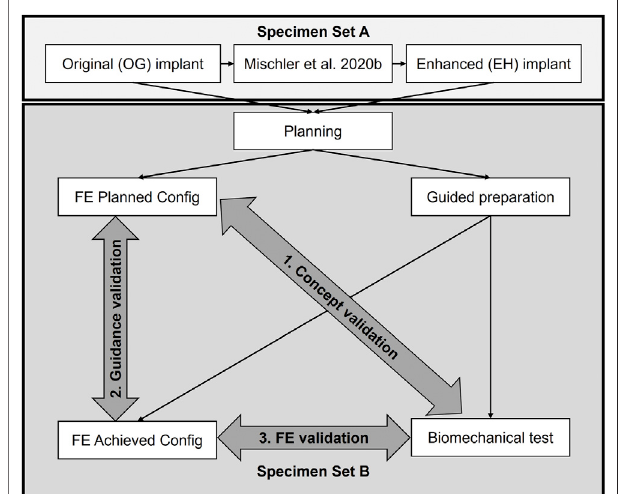
FIGURE 1 | Study overview. A computationally enhanced (EH) screw trajectory con fi guration was de fi ned based on the results of a previous fi nite element(FE)analysisstudy(SetA)andcomparedwiththeoriginal(OG)design via biomechanical testing on human cadaveric humerus specimens (Set B) to validate the concept of in silico design improvement (aim 1). The accuraciesoftheguidedinstrumentation (aim2)and thespecimenspeci fi cFE predictions (aim 3) were also validated based on the data of Set